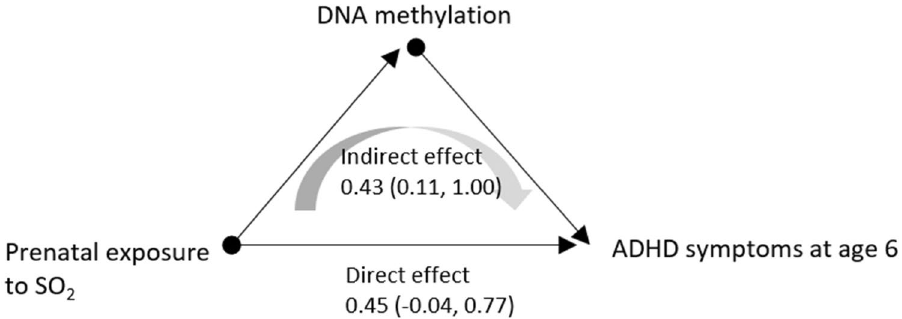
Figure 3. Mediation analysis showing the association between prenatal exposure to SO 2 and ADHD symptoms in children through DNA methylation at cg07583420 ( INS-IGF2